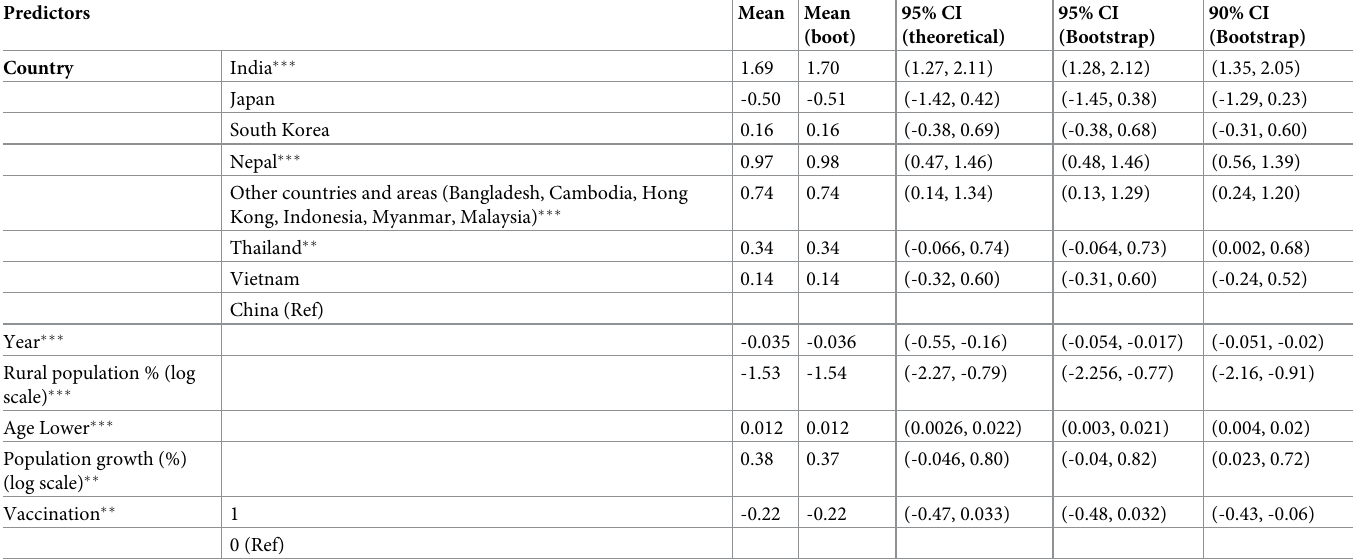
Table 2. Table of coefficients of predictors that were used in the inference model to fit Japanese encephalitis case-fatality ratio collated from systematic review. Mean, and 95% confidence interval (CI) were presented for both the model and bootstrap estimates. ��� indicates that odds ratio of the factor is different from 1 with a sig- nificance level of 95%; �� indicates that odds ratio of the factor is different from 1 with a significance level of 90%; Ref stands for reference category.; Rural population % is the percentage of rural population in the country; Age Lower is the minimum age of a laboratory confirmed JE